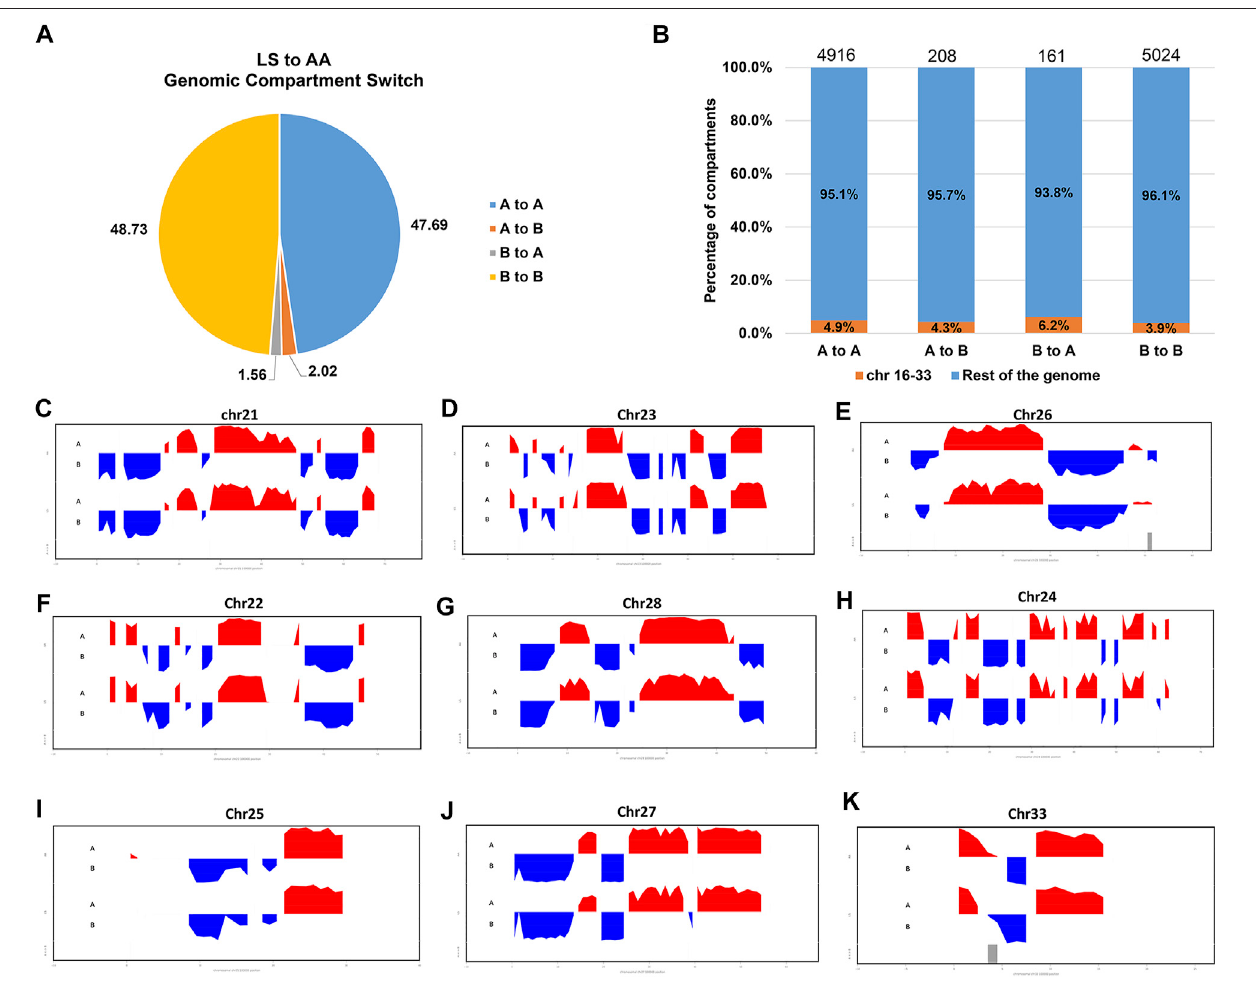
FIGURE3| Genomic compartmentalizationofAAand LSchickenbreast muscles. (A) Thegenomiccompartment changesbetweenAAandLS chickengenomes from breast muscles. “ A ” and “ B ” mean the open and closed compartments, respectively. “ A to A ” means open compartments in both chickens, “ B to B ” represents closedcompartmentsinbothchickens, “ AtoB ” meansthecompartmentsthatareopeninAAbutclosedinLS,and “ BtoA ” meansthecompartmentsthatareclosedin AA and open in LS. (B) The percentage of compartments that have switched (A to B or B to A) or been stable (A to A or B to B) between AA and LS chicken breast muscle genomes for chr16 through chr33 (orange) and the rest of the genome (blue). (C – K) First principal component of chr21, chr23, chr26, chr22, chr28, chr24, chr25, chr27 and chr33, respectively. The upward red irregular rectangles represent open A-type compartmentalization and the downward blue irregular rectangles represent closed B-type compartmentalization.